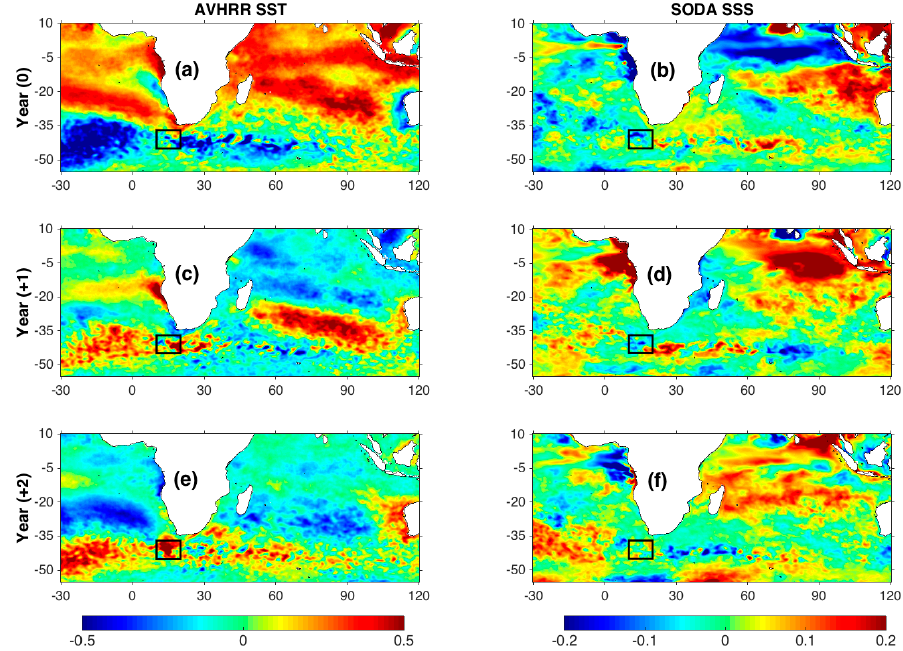
Figure 2. Same as Figure 1 except for all El Niño events listed in Table 1 during the peak ( a , b ), the following year ( c , d ), and two years after ( e , f